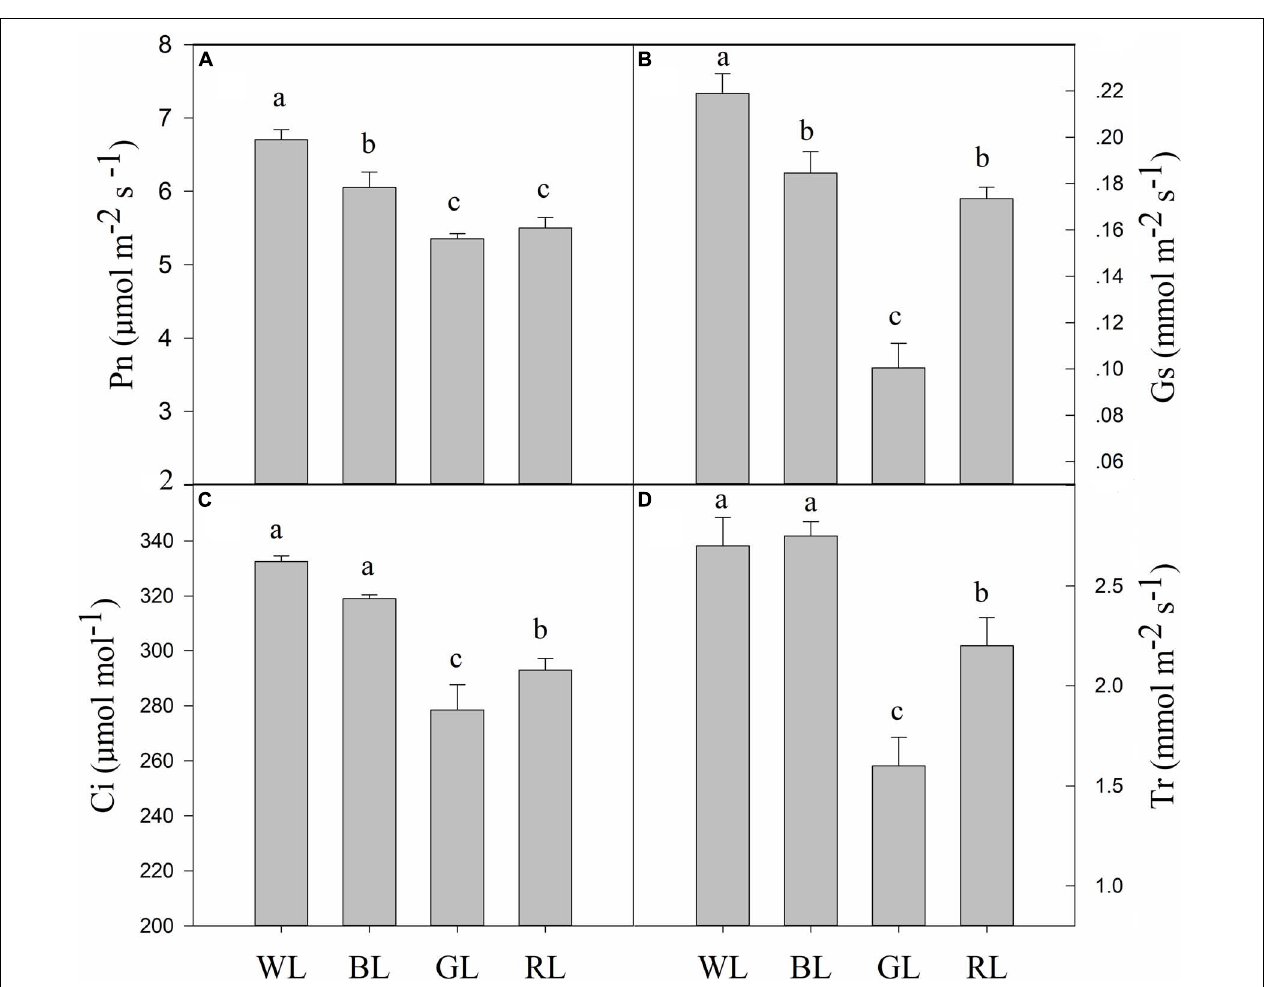
FIGURE 4 | Effects of light quality on gas exchange [Pn (A) , Gs (B) , Ci (C) , and Tr (D) ] in C. paliurus (Means ± SD). Different letters indicate significant differences ( P < 0.05) between LED light treatments according to ANOVA and LSD test, n =